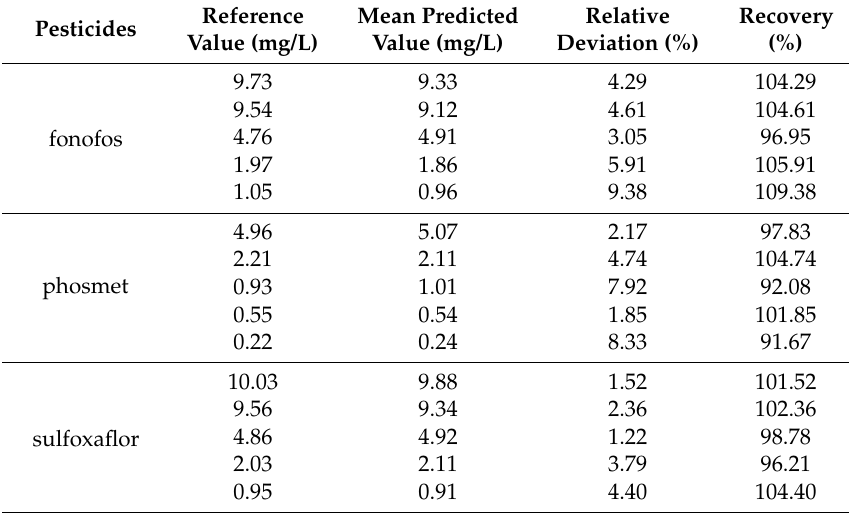
Table 3. The detection of the actual contaminated samples using the optimal